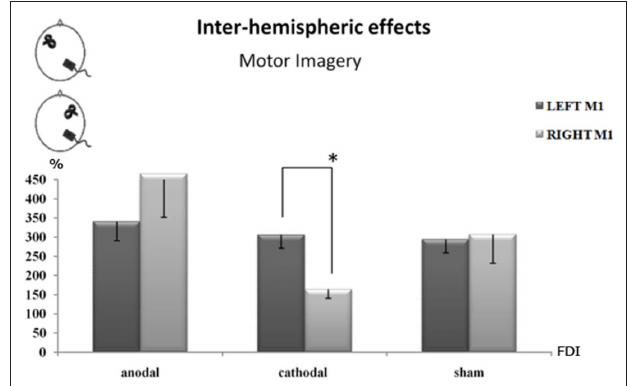
Figure A1 | Percentage changes of mean MePs’ amplitude values during the different experimental conditions. A value of 100% indicates, independently for each subject, the mean value during the baseline condition (before tDCS). The error bars correspond to 1 SE. An asterisk (*) indicates significant differences between the experimental conditions. tDCS was always delivered over the right parietal cortex. Cathodal tDCS significantly decreased the corticospinal facilitation induced by motor imagery, as indexed by the mean MEPs’ size, when TMS was applied on the right primary motor cortex with respect to the